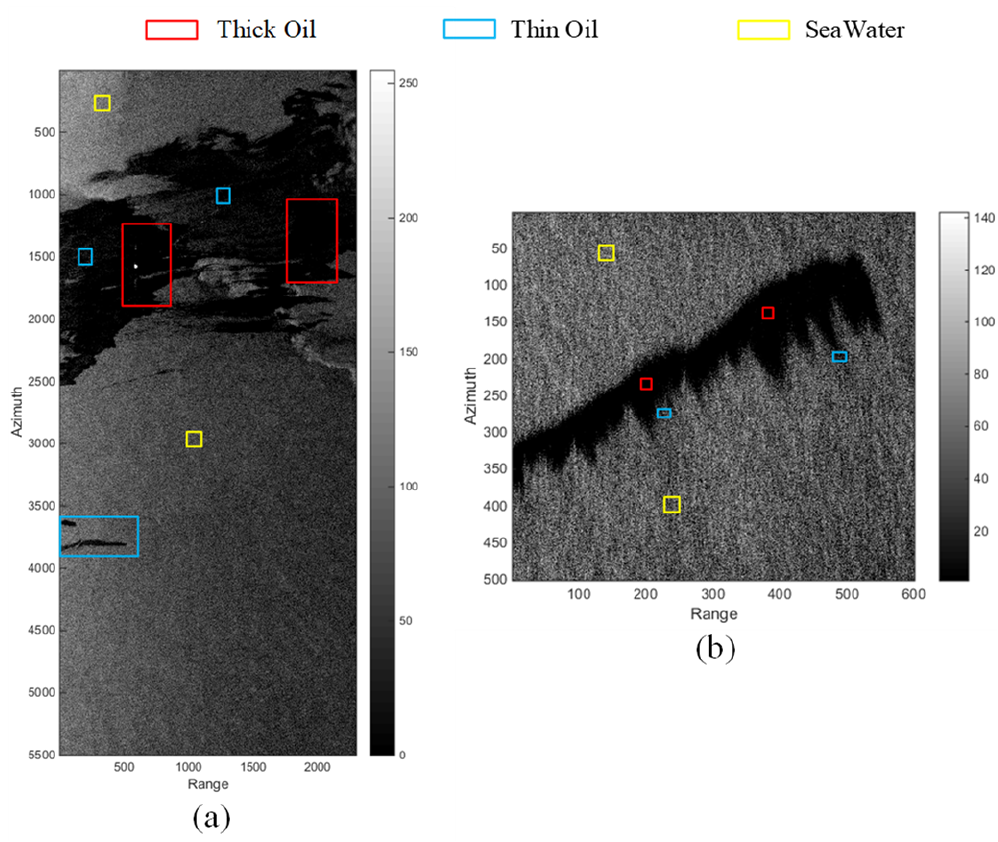
Figure 5. Span image of oil spill at sea: ( a ) Case 5; (b ) Case 6.